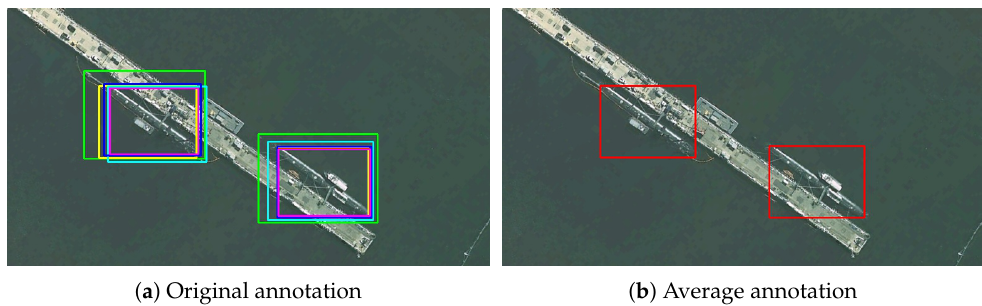
Figure 2. Annotation examples: ( a ) annotations marked by different subjects in different color rectangles, and ( b ) average annotation without